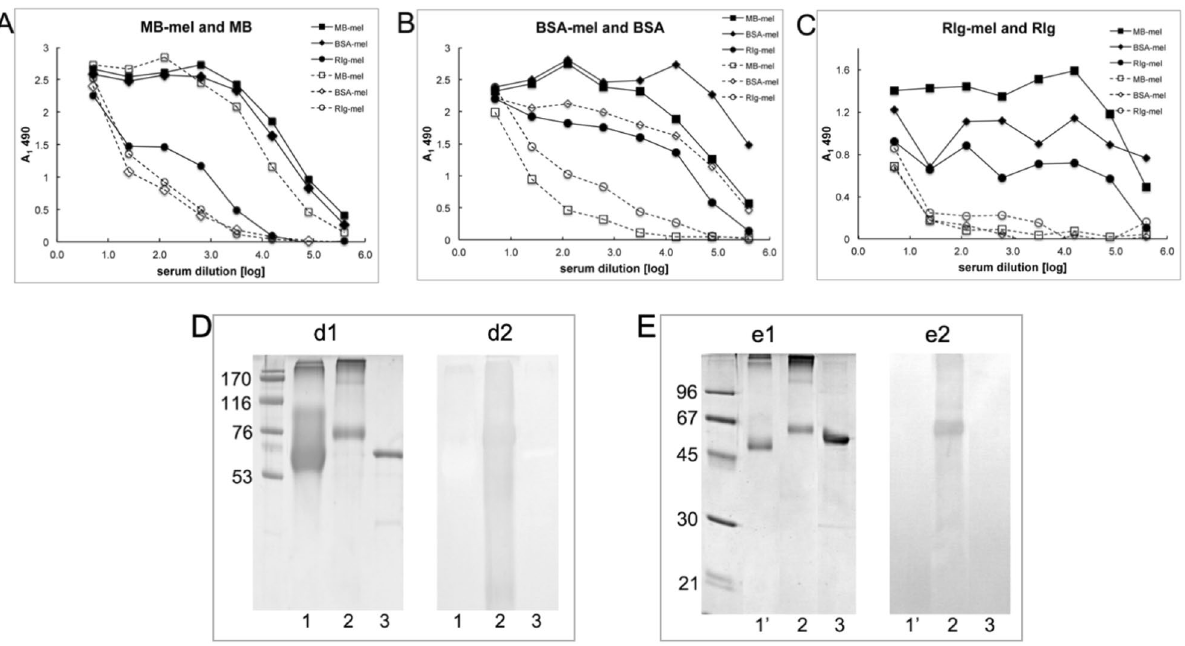
Figure 3. Characterization of the polyclonal anti-MAGE antisera. ELISA of anti-MB-mel, anti-BSA-mel, and anti-RIg-mel rabbit sera on plates coated with ( A ) MB-mel (solid lines) or MB (dashed lines); ( B ) BSA-mel (solid lines) or BSA (dashed lines); ( C ) RIg-mel (solid lines) or RIg (dashed lines); the results were normalized by subtraction of the absorption of secondary Ab (PBS in place of serum) and expressed as A 1 490. The glycation products generated from melibiose show different antigenic properties than products formed from ( D ) glycolaldehyde (GA) and ( E ) methylglyoxal (MGO). The samples were as follows: (1) BSA-GA (24 µg), (1 ′ ) BSA-MGO (2 µg), (2) BSA-mel (1 µg), (3) BSA (2 µg) were resolved in 10% polyacrylamide gel stained with CBB ( d1 , e1 ) or transferred onto PVDF membrane for Western blotting ( d2 , e2 ) with the anti-MAGE (MB-mel) rabbit